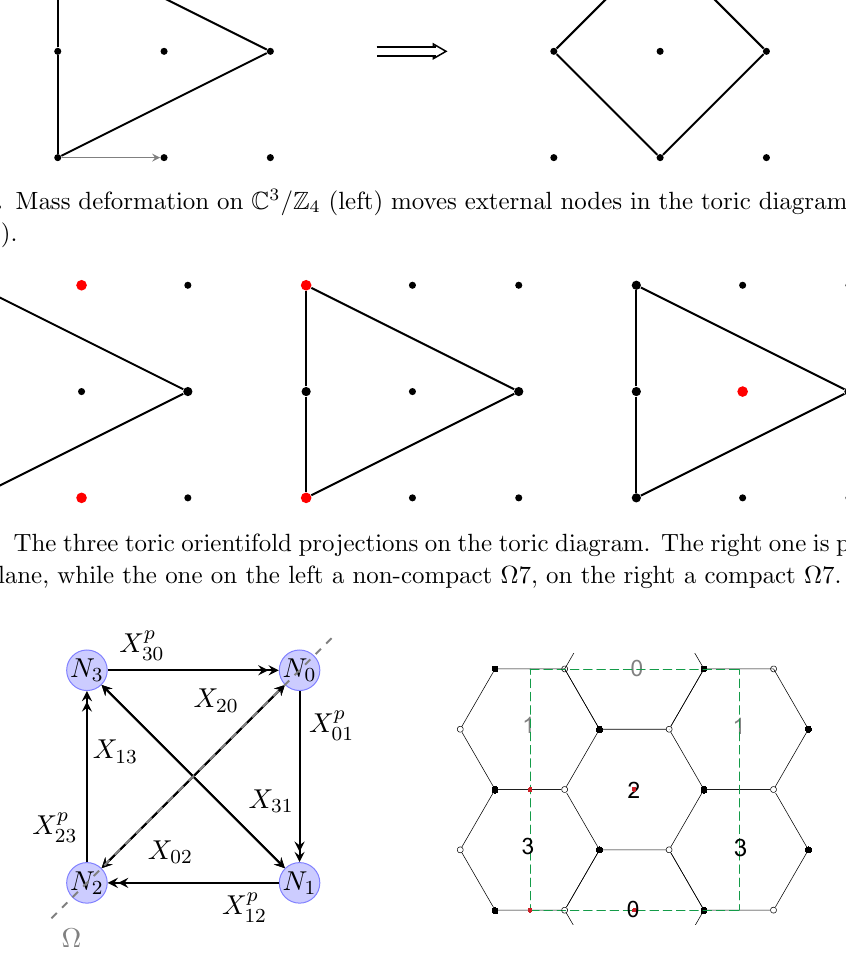
Figure 27. The quiver and the corresponding dimer for the orientifold projection (cid:10) of C 3 = Z 4 . Orientifold (cid:10) of C 3 = Z 4